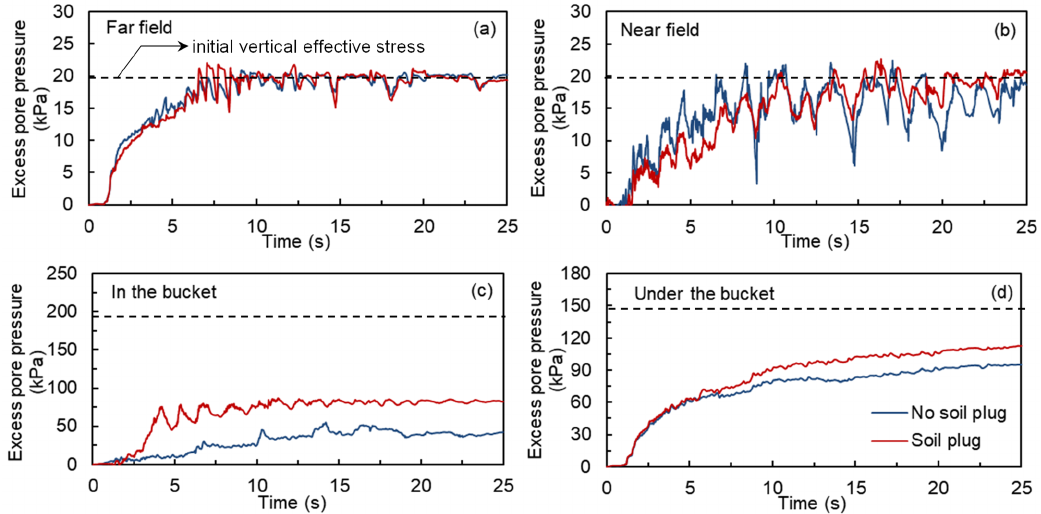
Figure 6. Excess pore pressure time histories of seabed soil for simulations with and without soil plug in 50% relative density inclined liquefiable seabeds: ( a ) far field seabed soil at 2.0 m depth; ( b ) near field seabed soil at 2.0 m depth; ( c ) seabed soil in the bucket at 2.0 m depth; ( d ) seabed soil under the bucket at 12 m depth.